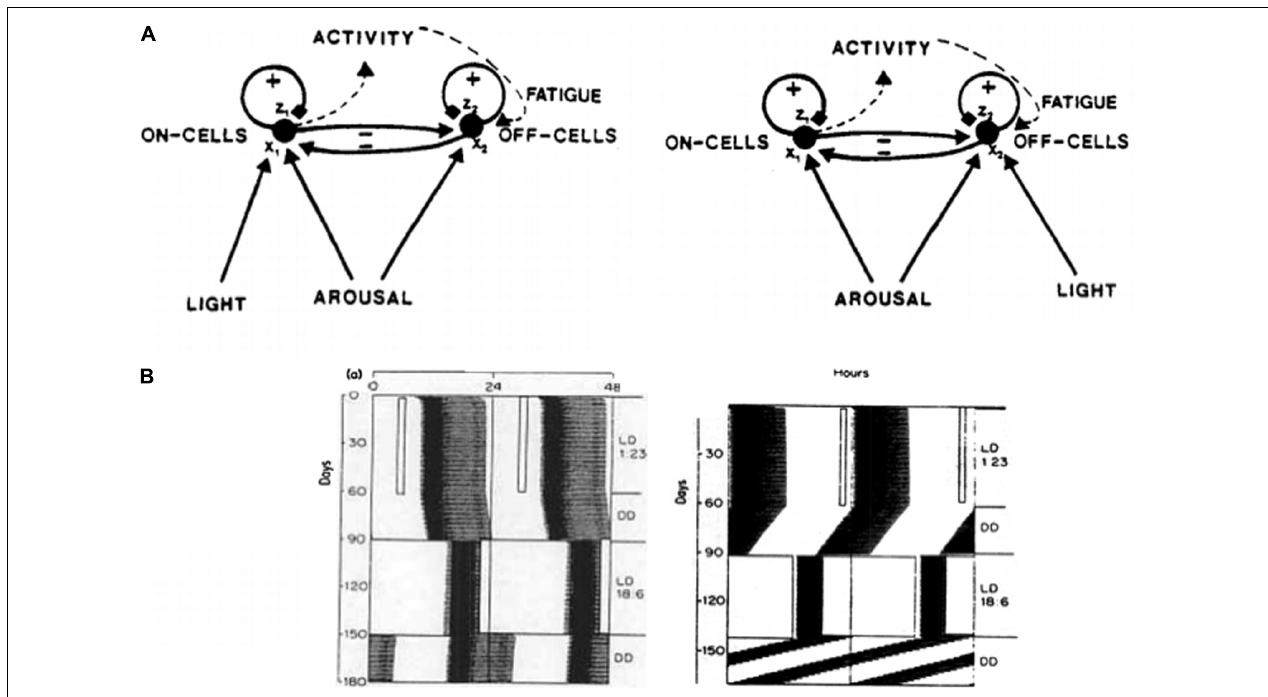
FIGURE 14 | (A) Diurnal and nocturnal gated pacemaker circuits of the circadian oscillator in the suprachiasmatic nuclei (SCN). In both of these recurrent circuits, ON cells and OFF cells excite themselves via positive feedback, inhibit each other via negative feedback, and are tonically aroused. Light excites ON cells in the diurnal circuit and OFF cells in the nocturnal circuit. Activation of ON cells or suppression of OFF cells energizes wakefulness and activity. Fatigue builds up during the wakeful state and excites OFF cells in both diurnal and nocturnal circuits. (B) Two computer simulations of photoperiod after-effects. In both simulations, the model is exposed to a Light-Dark (LD) 1:23 lighting regime (1 h of light every 24 h) before free-running in the dark. Then the model experiences a LD 18:6 lighting regime before free-running in the dark. The free-running activity levels and periods depend upon the prior lighting regimes and persist through the 30-day free-run intervals. Each figure is a double-plot. Two successive days are plotted in each row and each successive day is plotted in the left-hand column. Thus the day plotted in the right-hand column of the i th row is also plotted in the left-hand column of the (i + 1) st row. [Reprinted with permission from Carpenter and Grossberg